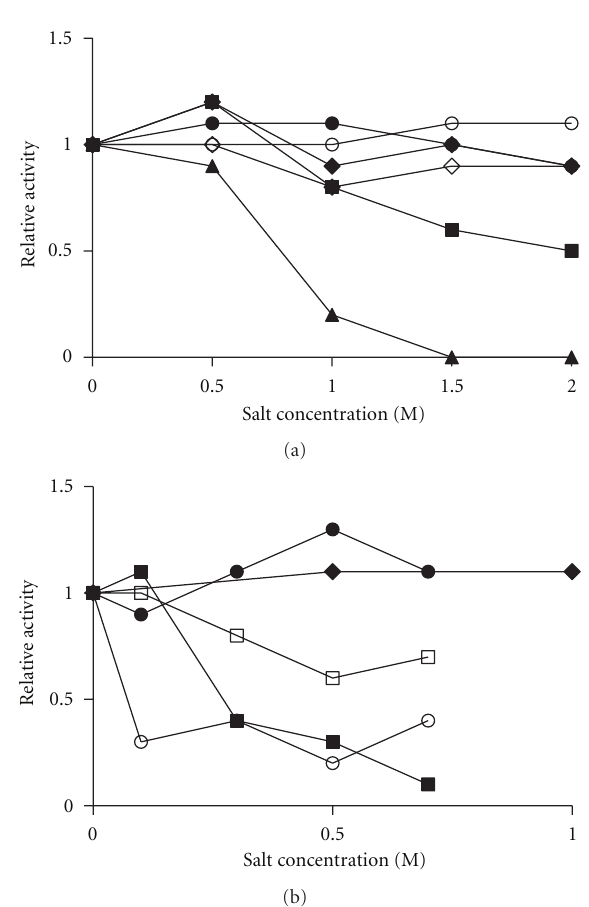
Figure 4: Salt influence on CeSP activity. Hydrolysis of H-D-Pro- Phe-Arg-pNA by CeSP was determined in absence or presence of (a) NaCl ( • ), NaBr ( (cid:2) ), NaI ( (cid:3) ), Na 2 SO 4 ( ♦ ), NaH 2 PO 4 ( ◦ ), and NaC 2 H 3 O 2 ( (cid:5) ); (b) KCl ( • ), NaCl ( (cid:5) ), NH 4 Cl ( ◦ ), MgCl 2 ( (cid:6) ), and CaCl 2 ( (cid:2) ).